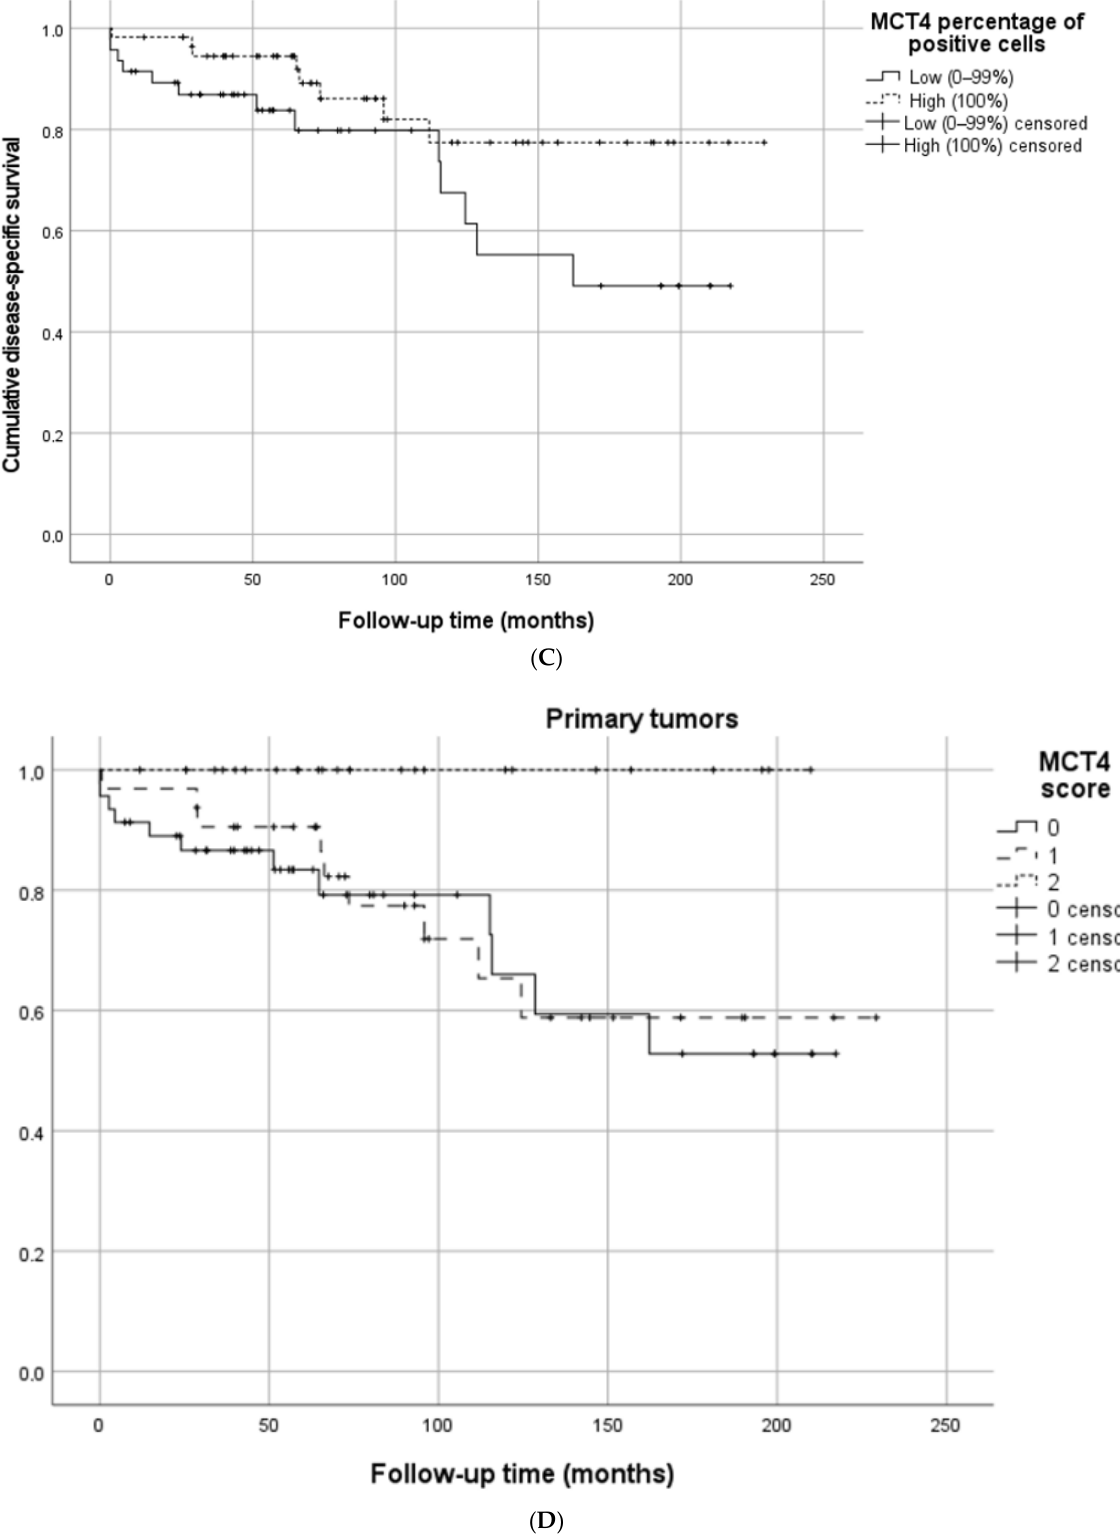
Figure 2. Cumulative disease-specific survival in primary small bowel neuroendocrine tumors stratified by ( A ) MCT1 score, ( B ) MCT4 staining intensity, ( C ) MCT4 percentage of positive cells, and ( D ) MCT4